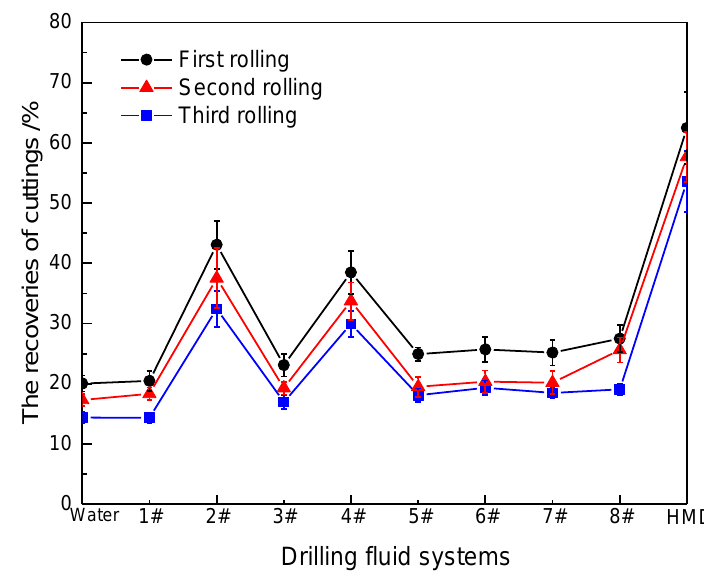
Figure 8. The effect of filtrates of different drilling fluids on the cutting recoveries. Figure 8. The e ff ect of filtrates of di ff erent drilling fluids on the cutting